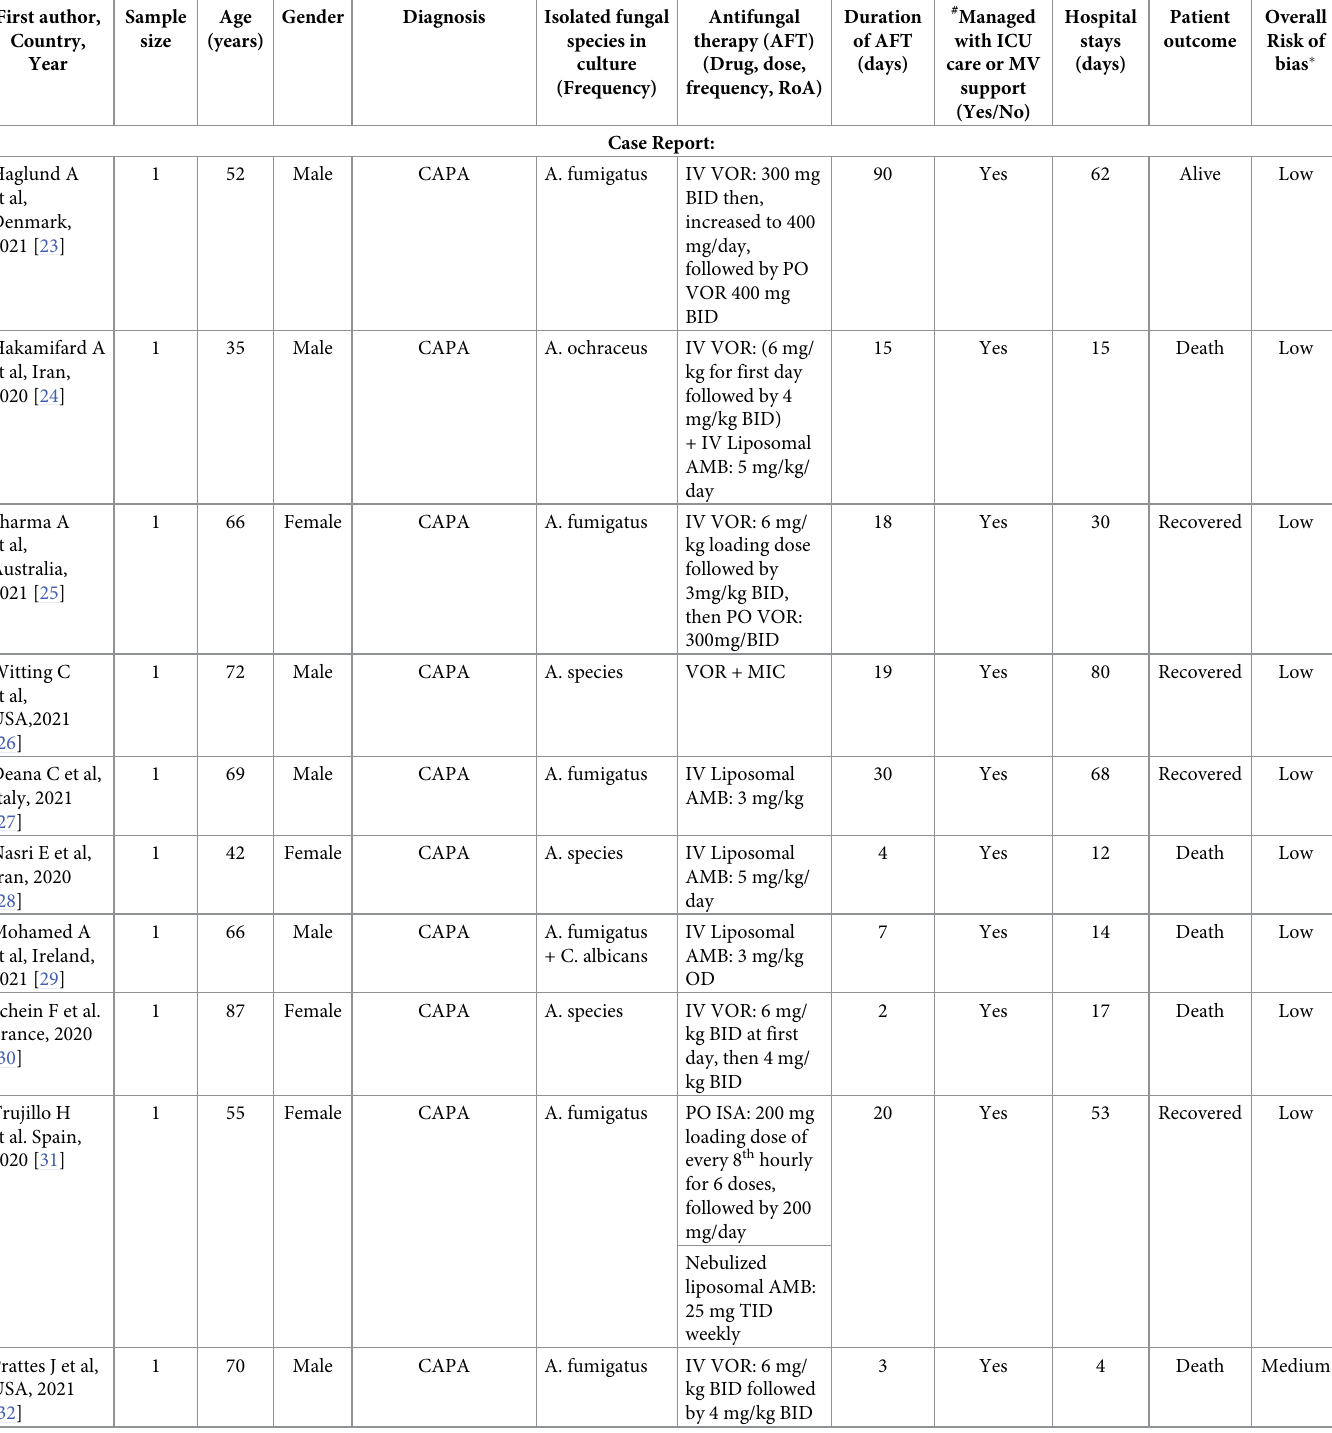
Table 1. Study characteristics of case reports and case series